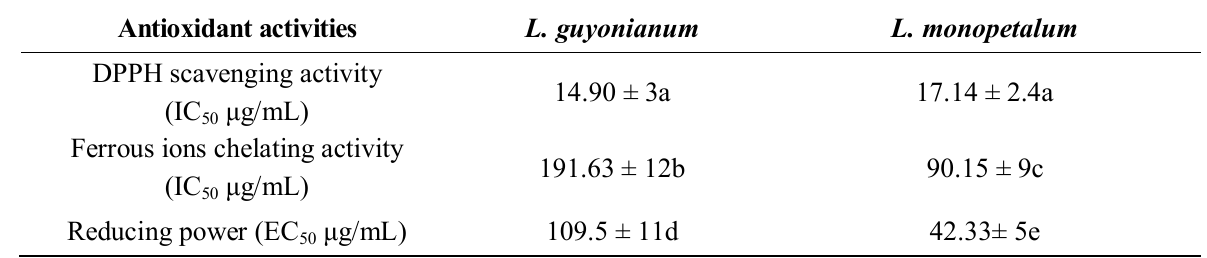
Table 3. Antioxidant activities of Limoniastrum guyonianum and Limoniastrum monopetalum leaves. Data are the average of three replications ± SD. Means sharing at least one same letter are not significantly different according to Tukey test at p <